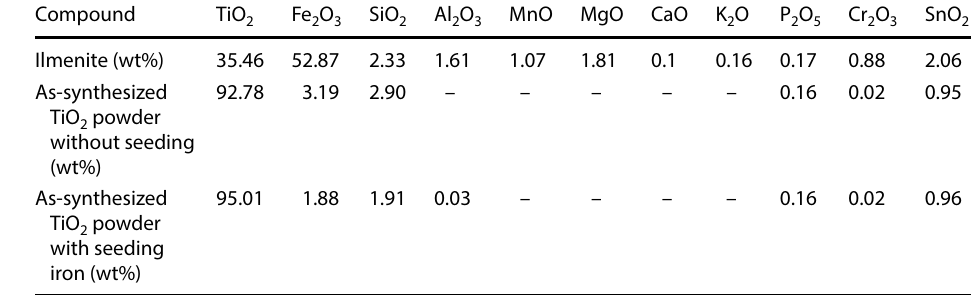
Fig. 4 XRD patterns of ilmen- ite, the synthesized solids and the reference TiO ( ● ilmenite, 2 ◊ anatase, ♦ rutile, reference TiO in Evonik P 25). (adapted 2 from Ref.